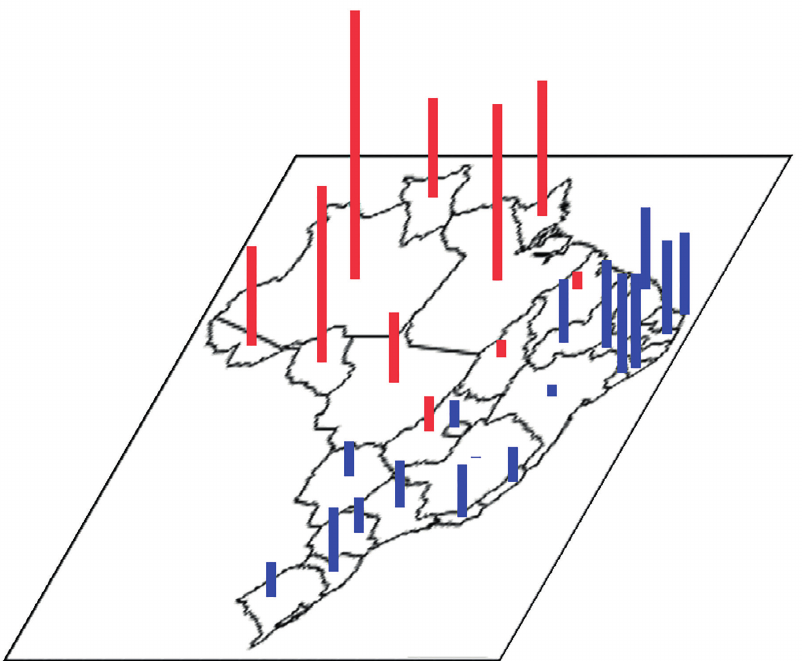
Figure 5 - Relative date of 50% knowledge for Brazilian states. Red columns in years behind the average for Brazil (maximum Amazonas state -66 years) Blue columns ahead of the average (maximum 17 years - several northeast states)